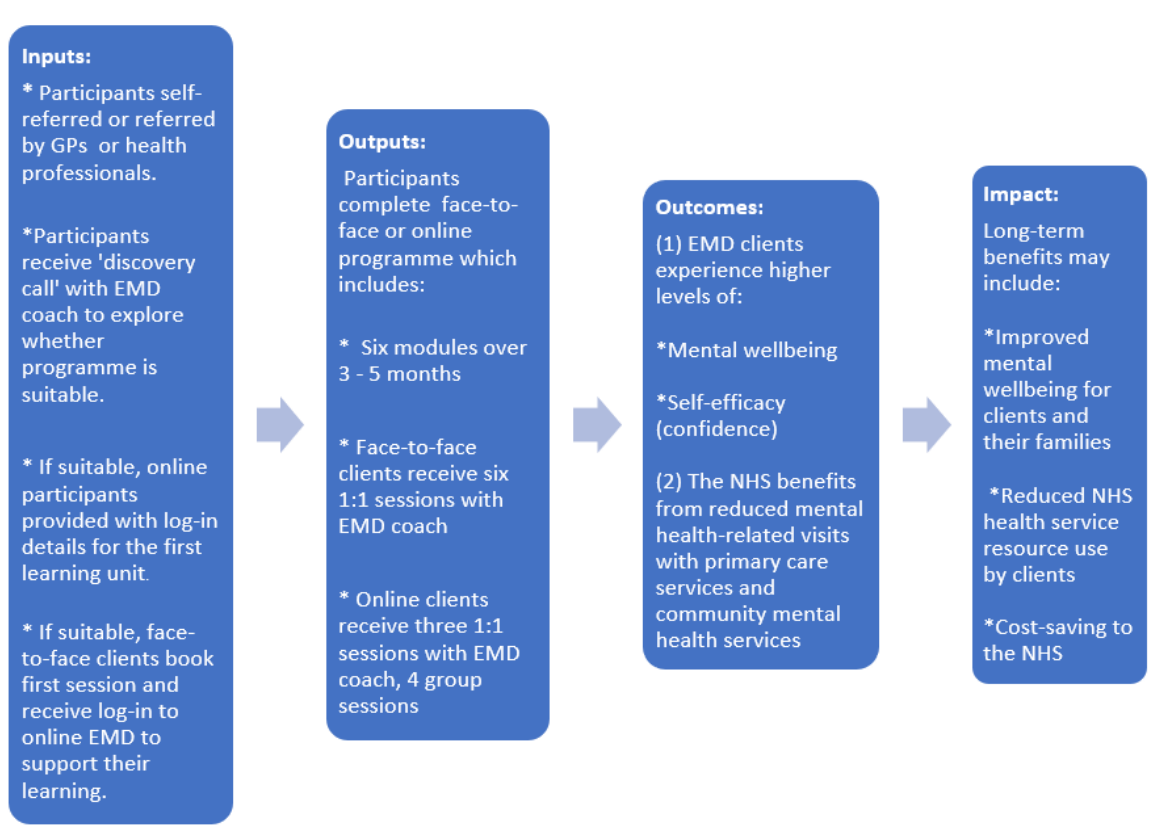
Figure 2. Theory of change model.